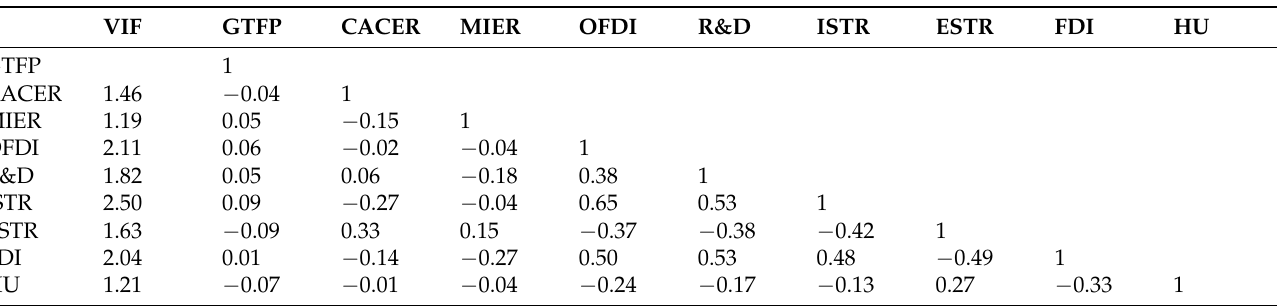
Table 5. The correlation and multicollinearity